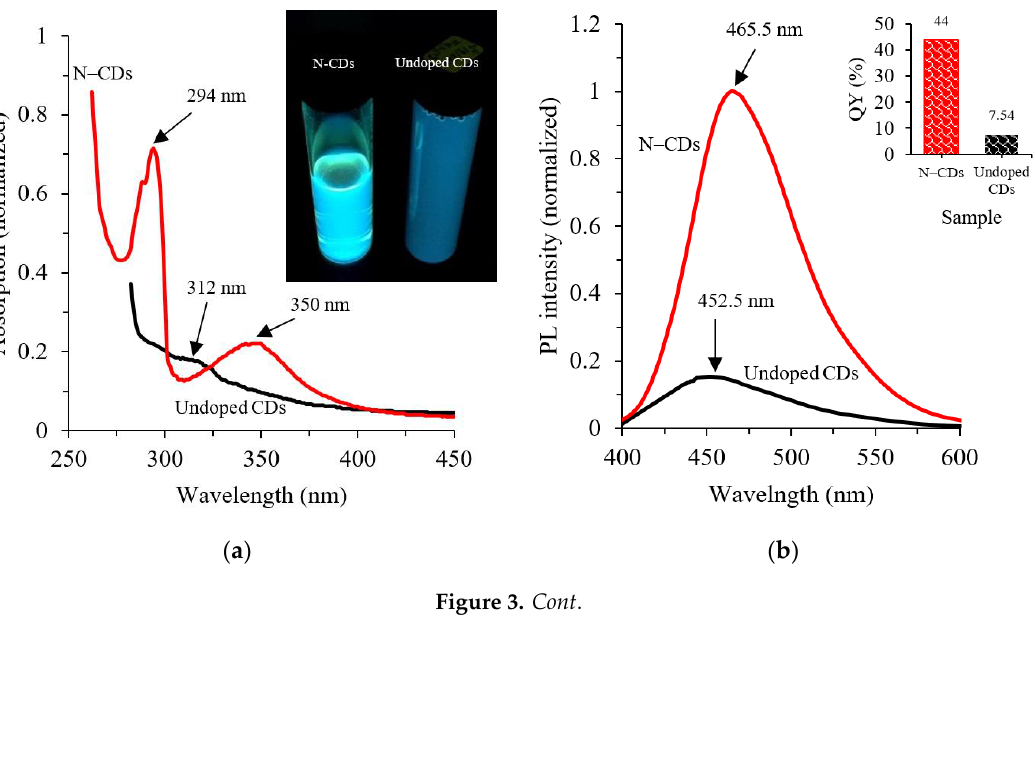
Figure 2. ( a ) FTIR analysis of undoped (black line) and N–CDs (red line), ( b ) X-ray photoelectron spectrum (XPS) of N–CDs, ( c ) high-resolution XPS for C 1s , ( d ) high-resolution XPS spectra for N 1s and ( e ) high-resolution XPS spectra for O 1s .